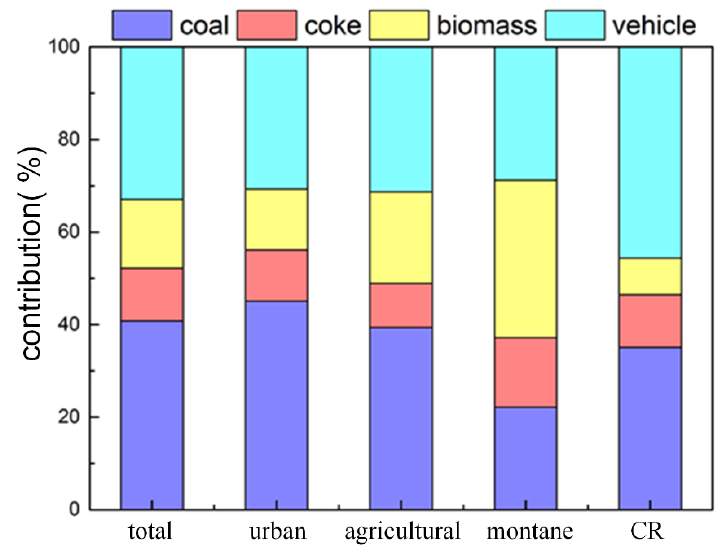
Figure 6. Contribution profile of total, urban, agricultural, montane samples, and carcinogenic risk (CR).